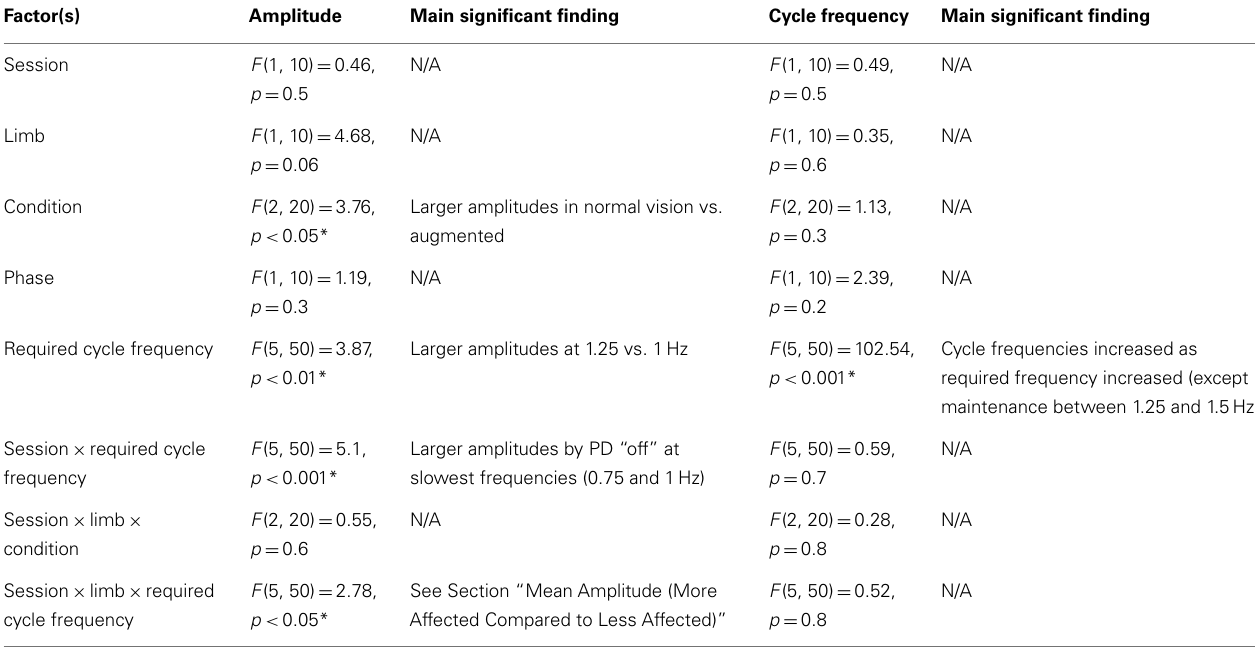
TableA4 | Statistical results fromANOVA analysis on planned comparison between PD “off” and PD “on” to evaluate the effects of dopaminergic treatment on amplitude and frequency of